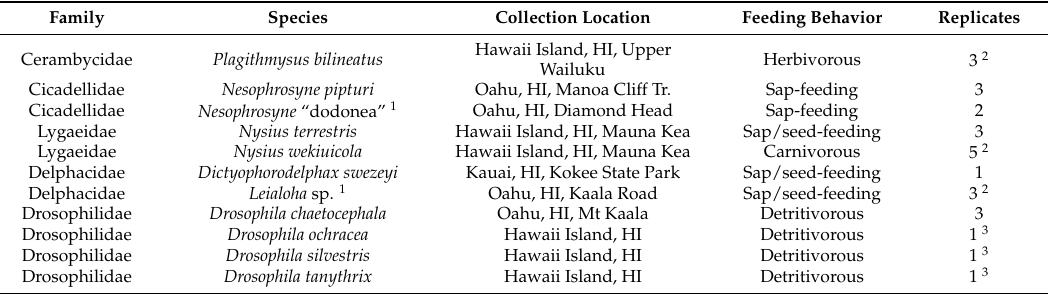
Table 1. Taxon sampling for 16S bacterial